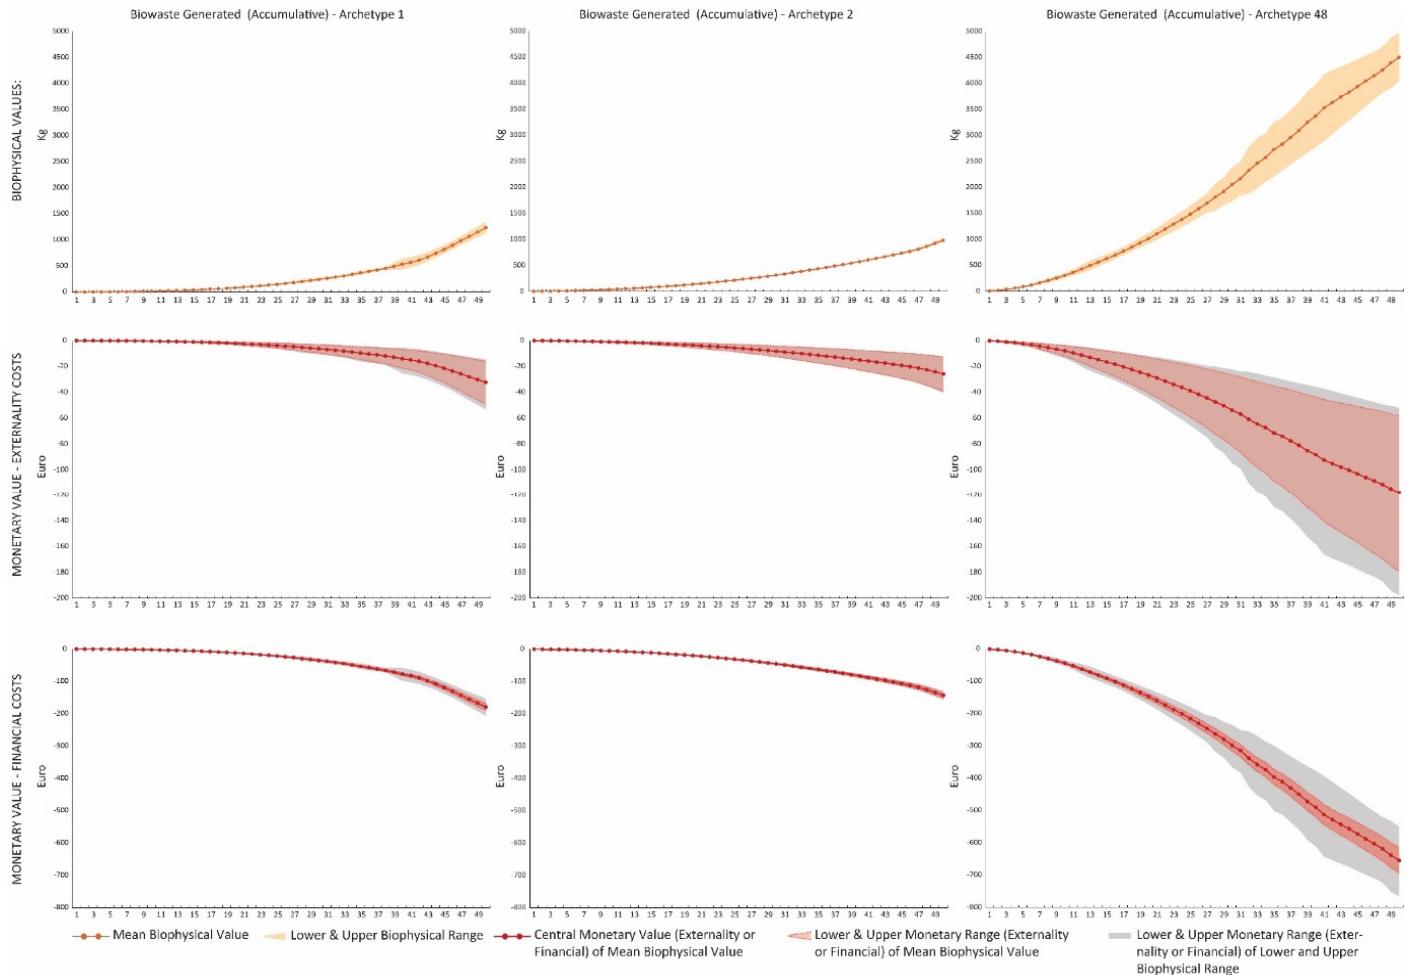
Figure 11. Comparison of biophysical and monetary performance over time for “Management of waste from litter” in archetypes 1, 2, and 48. Results are shown as cumulative values over time (i.e., value at year 50 is the accumulated value from year 1 to 50).